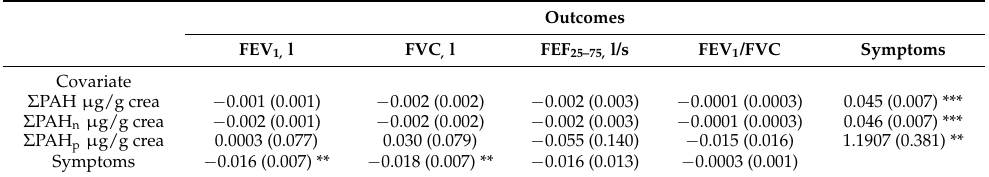
Table 5. Estimate and (SE) from generalized mixed models.